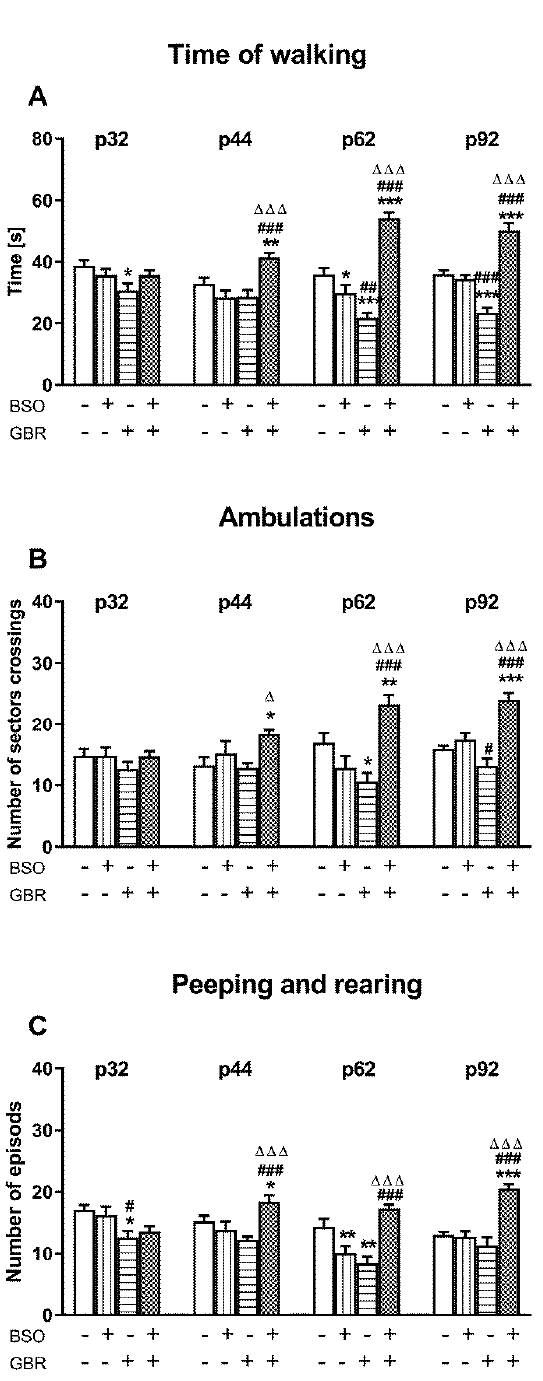
Figure 3. The effect of chronic administration of BSO and GBR 12909, alone or in combination, during postnatal days p5–p16 on positive symptoms assessed in the OFT in adolescent and adult Sprague– Dawley rats as: ( A ) the time of walking ( B ) the number of sector crossings ( C ) the number of peeping and rearing episodes. Data are presented as the mean ± SEM, n = 10 for each group. Statistical analysis was performed using a two-way ANOVA; symbols indicate significance of differences according to the Newman–Keuls post hoc test, *** p < 0.001, ** p < 0.01, * p < 0.05 vs. control; ### p < 0.001, ## p < 0.01, # p < 0.05 vs. BSO and ∆∆∆ p < 0.001, ∆ p < 0.05 vs. GBR 12909-treated